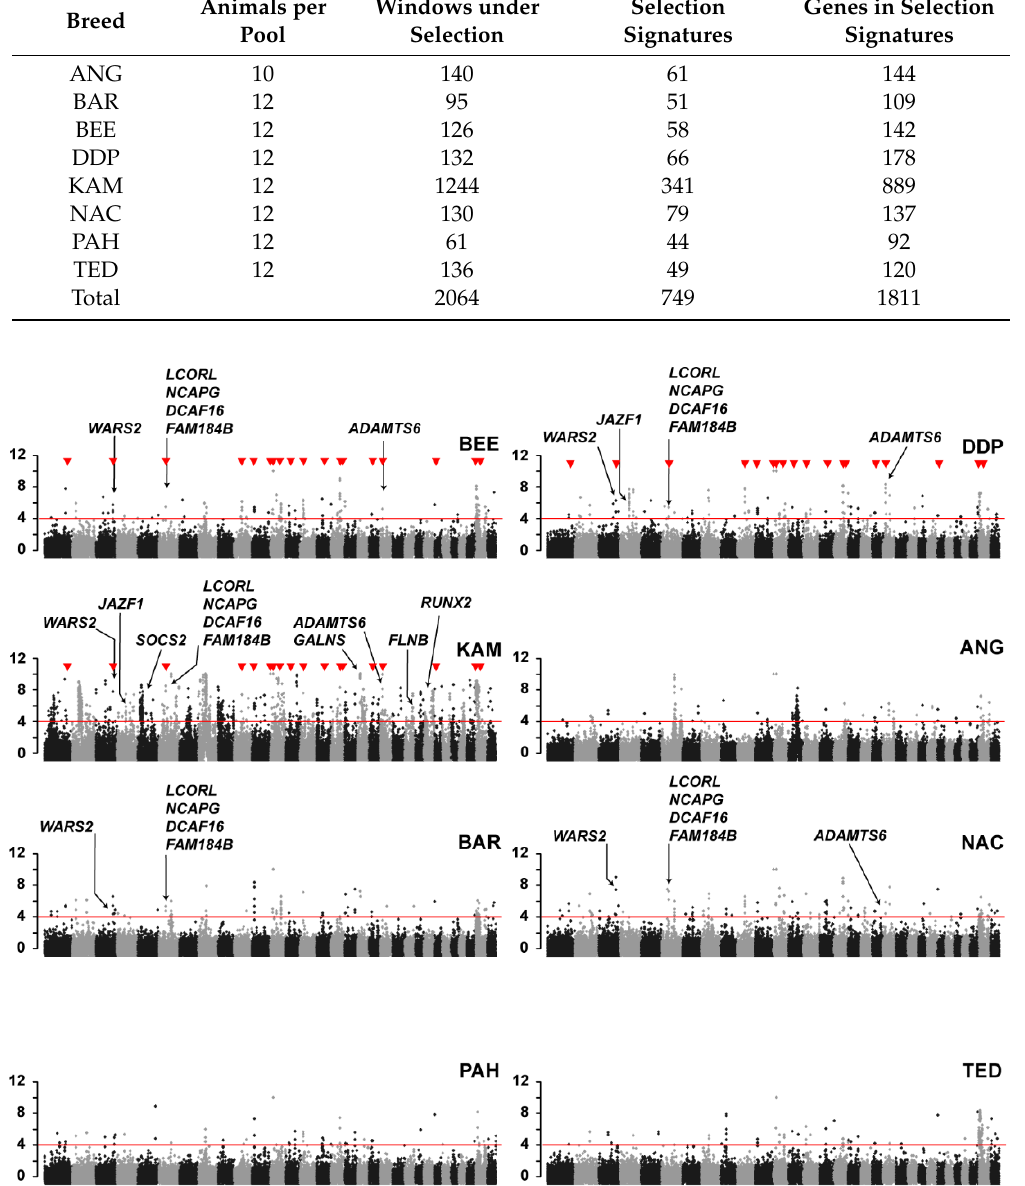
Figure 2. Manhattan plots illustrating the observed selection signatures in eight Pakistani goat breeds. Red triangles indicate 18 selection signatures that are shared between three breeds of large-sized goats (BEE, DDP, KAM). Selection signatures that harbor genes known to be related to height or body size in other species are indicated.